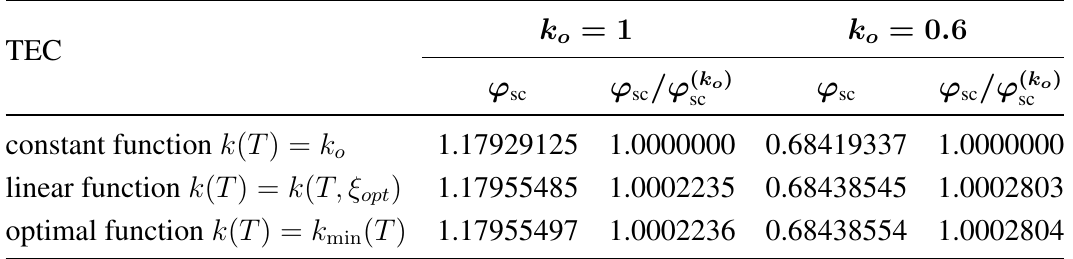
= 270 K and T = 300 K a s